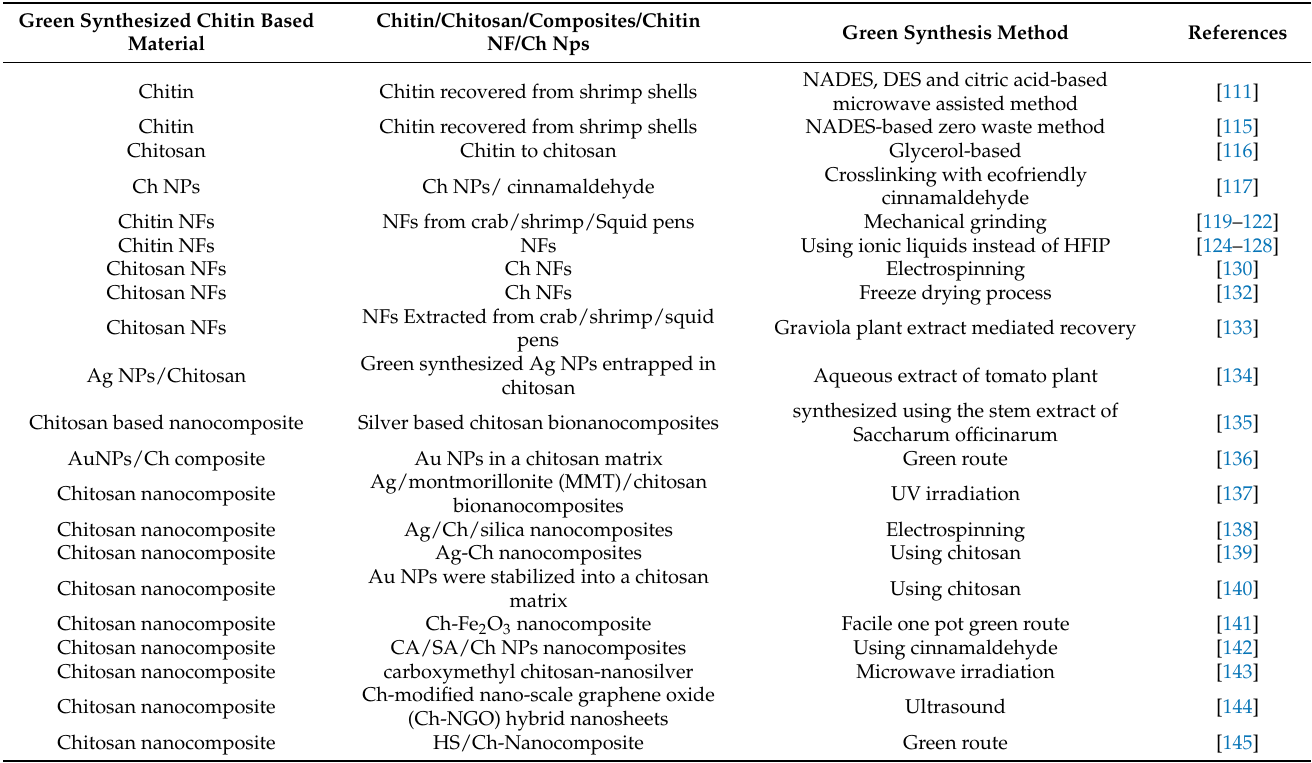
Table 1. List of green synthesized chitin-based